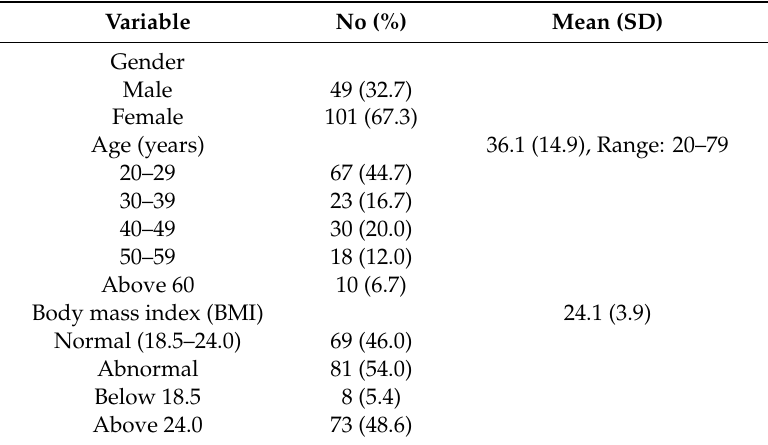
Table 2. Characteristics of the participants (N =